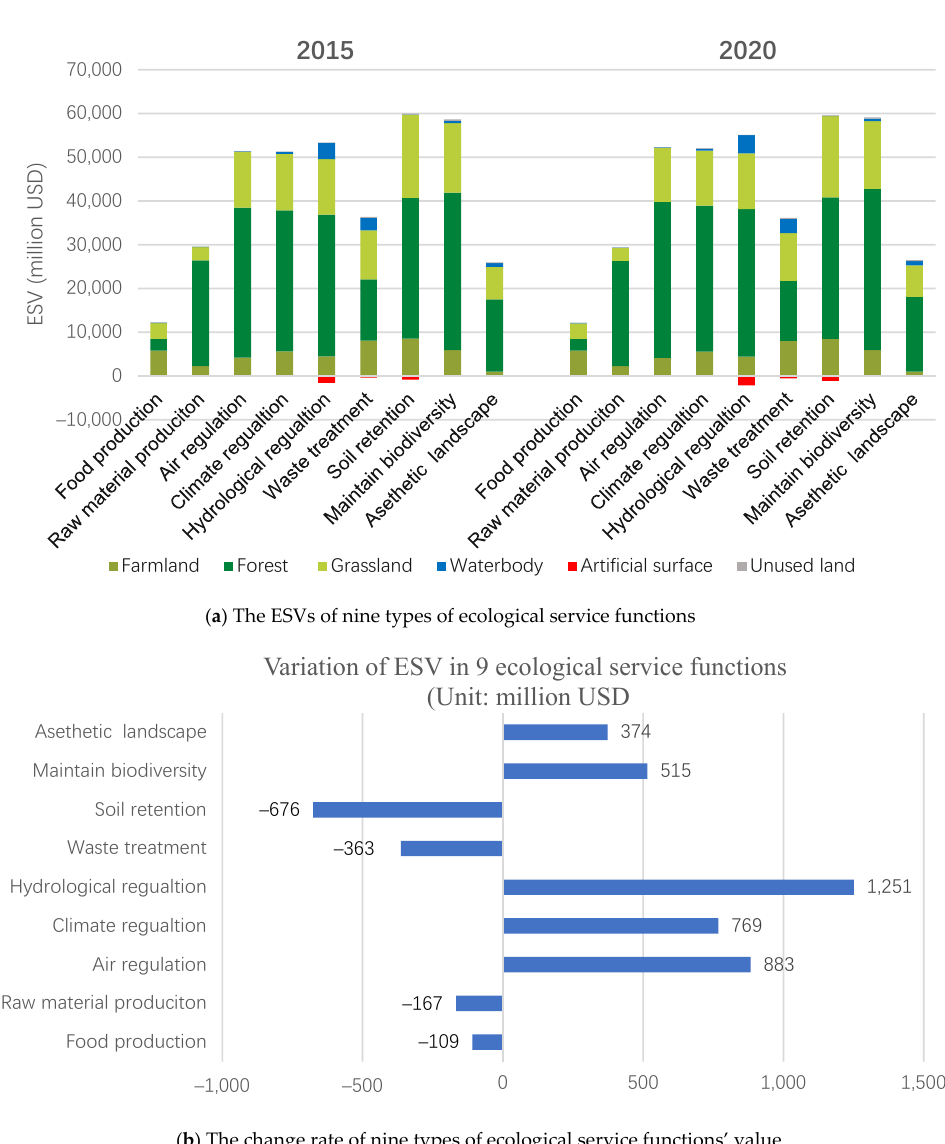
Figure 8. The variation of ESVs of nine types of ecological service functions in Sichuan province during 2015–2020.